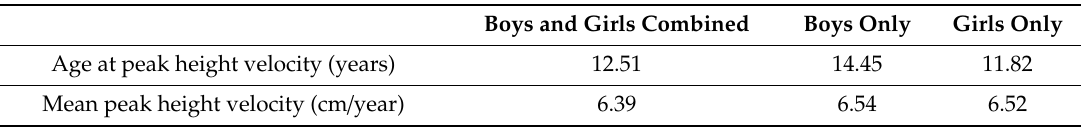
Table 1. Comparison of mean